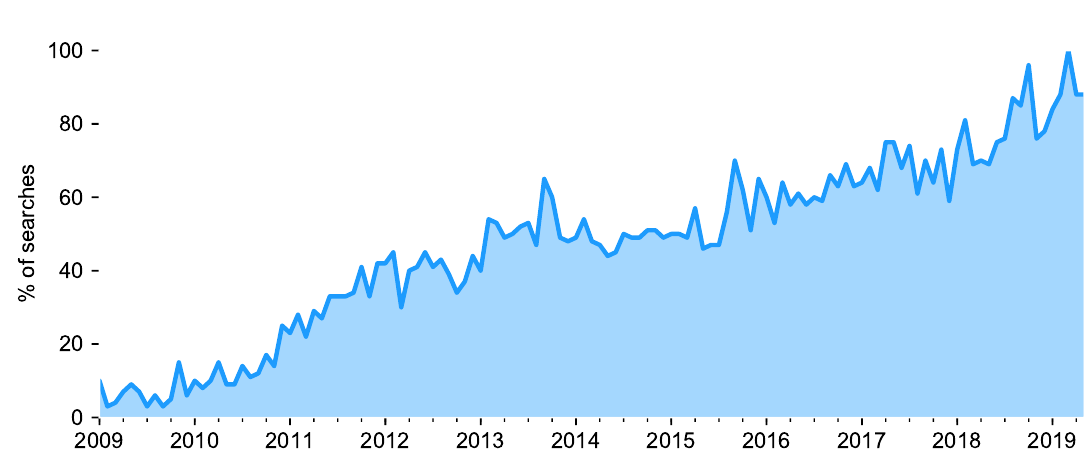
Figure 1. Number of searches of “mood app” during the last 10 years. Values expressed in percentage relative to the total amount of searches on that topic. Source: Google Trends